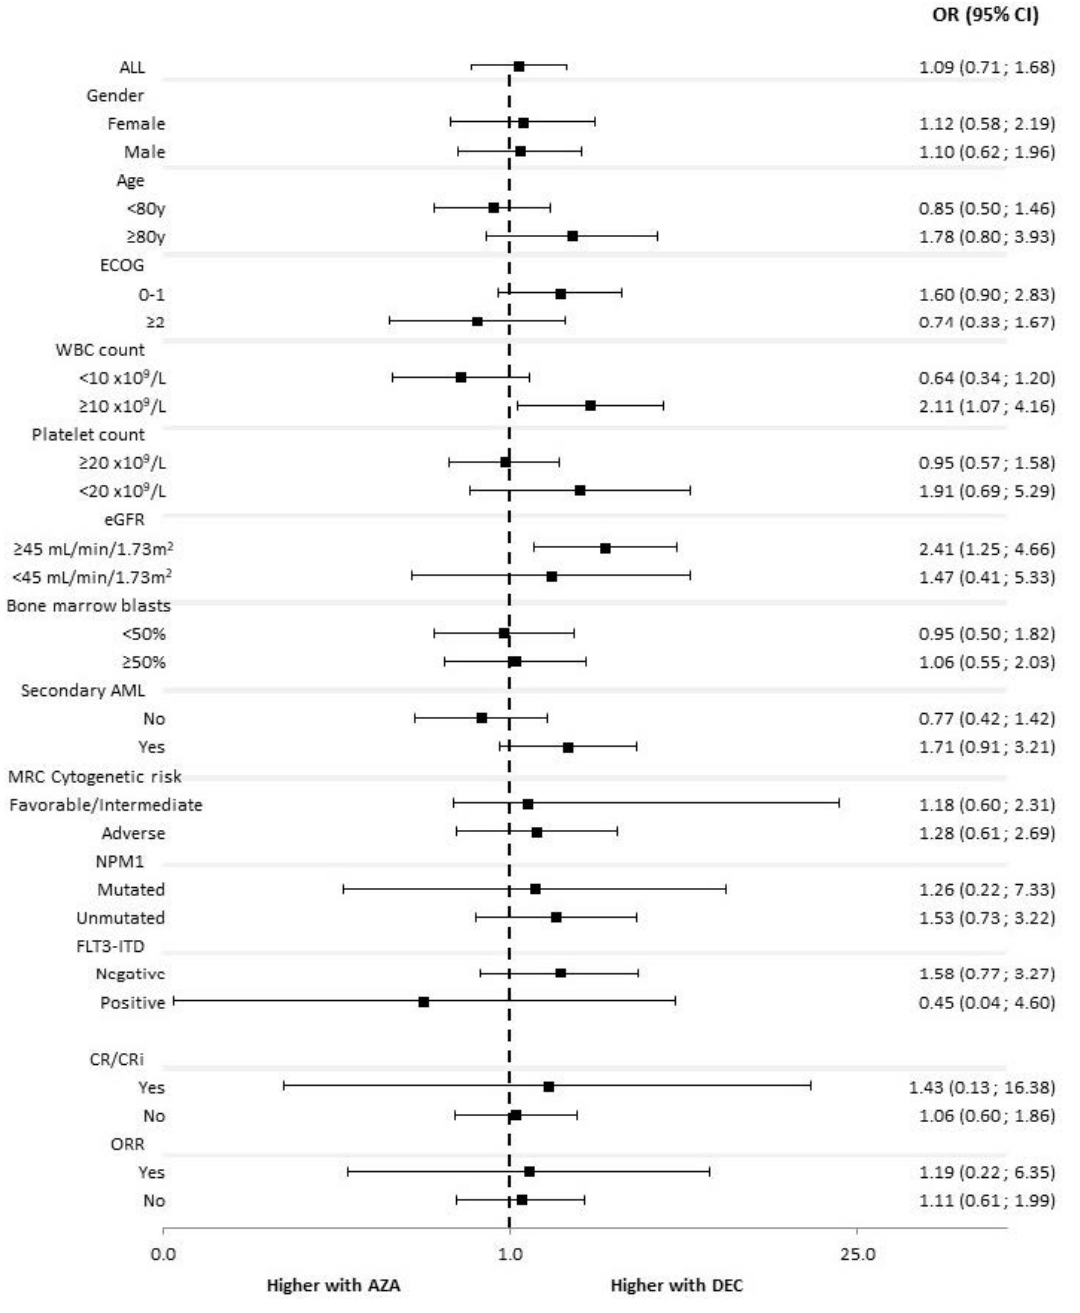
Figure 3. Subgroup analysis for 120-day mortality. AML, Acute myeloid leukemia; AZA, azacitidine; CR, complete remission; CRi, complete remission with incomplete blood count recovery; DEC, decitabine; ECOG, Eastern Cooperative Oncology Group; eGFR, estimated glomerular filtrate rate; FLT3, FMS-like tyrosine kinase 3; ITD: internal tandem duplication; MRC, Medical Research Council; NPM1, Nucleophosmin1; ORR, overall response rate (CR + CRi + PR); PR, partial remission; WBC, white blood